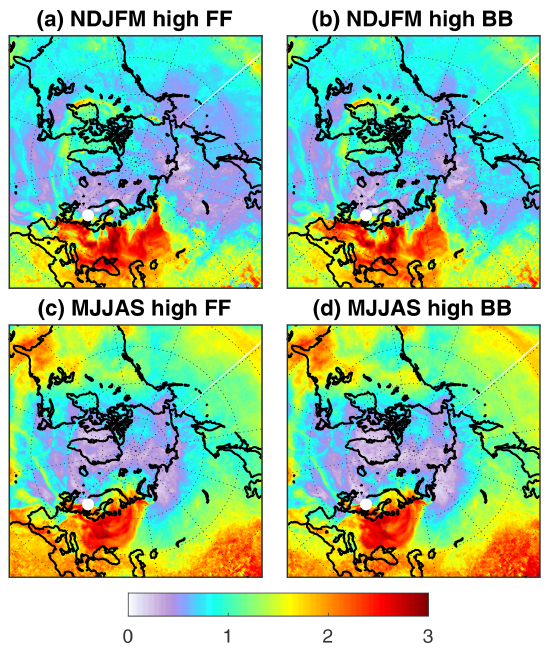
Figure 7. The 70th percentiles of eBC FF (a, c) and eBC BB (b, d) for winter (NDJFM) and summer (MJJAS). The colour code shows the ratio of residence times for footprint sensitivities during mea- surements exceeding the 70th percentile and the average footprint